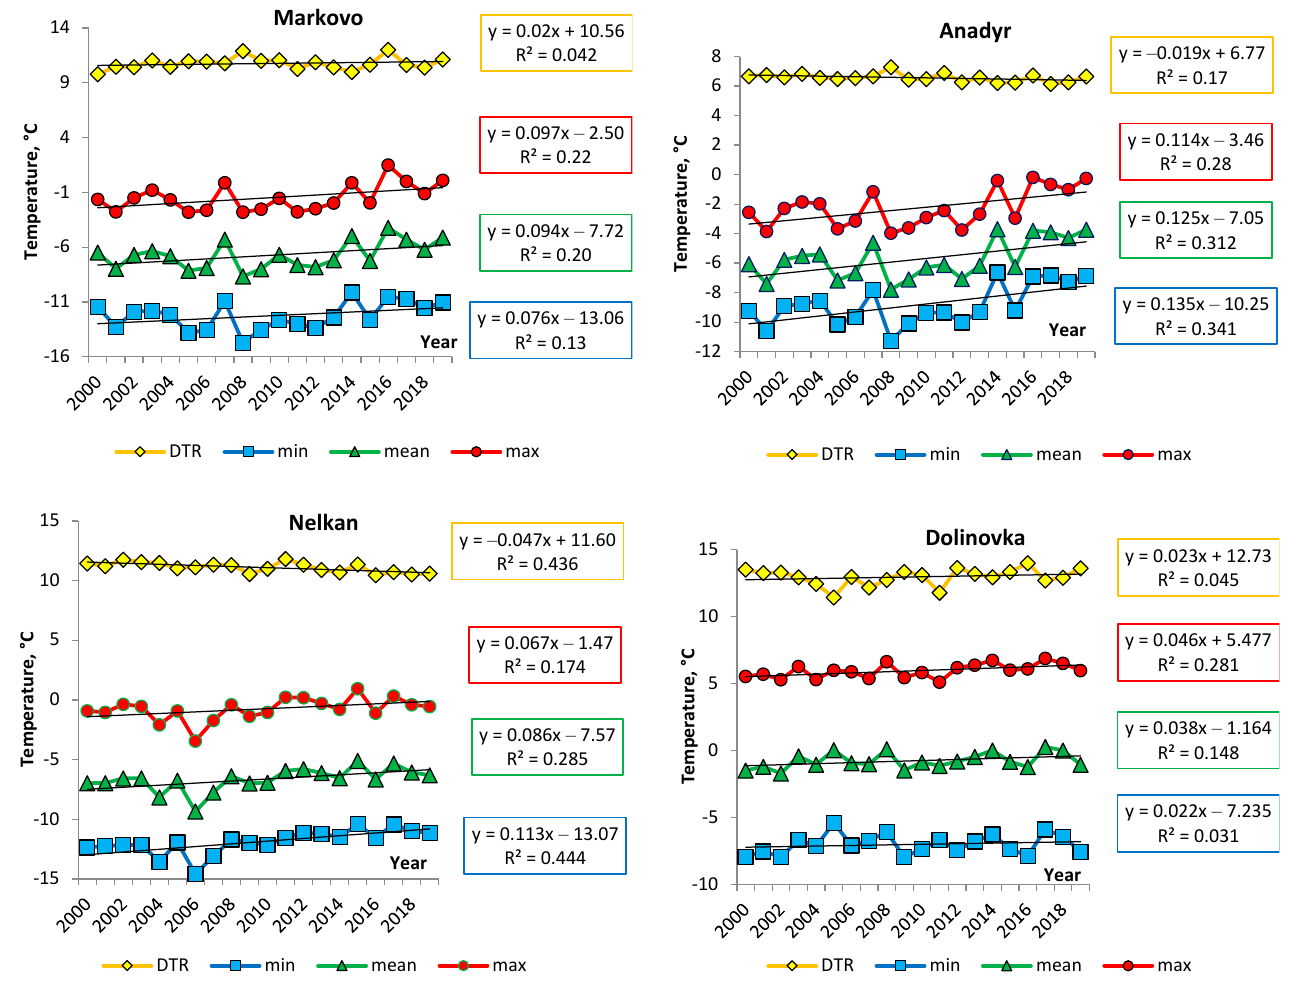
Figure 6. Temporal dynamics of minimum, mean, maximum air temperatures, and DTR, for several weather stations at the RFE during the study period from 2000 to 2019. Black solid lines show the linear trend of the correspondent series. Table 2. Temporal trends (°C per 10 years) of daily temperatures for some continental and coastal locations at the Russian Far East, where trends are significant according to the Mann–Kendall test at the 0.05 level, 2000–2019.